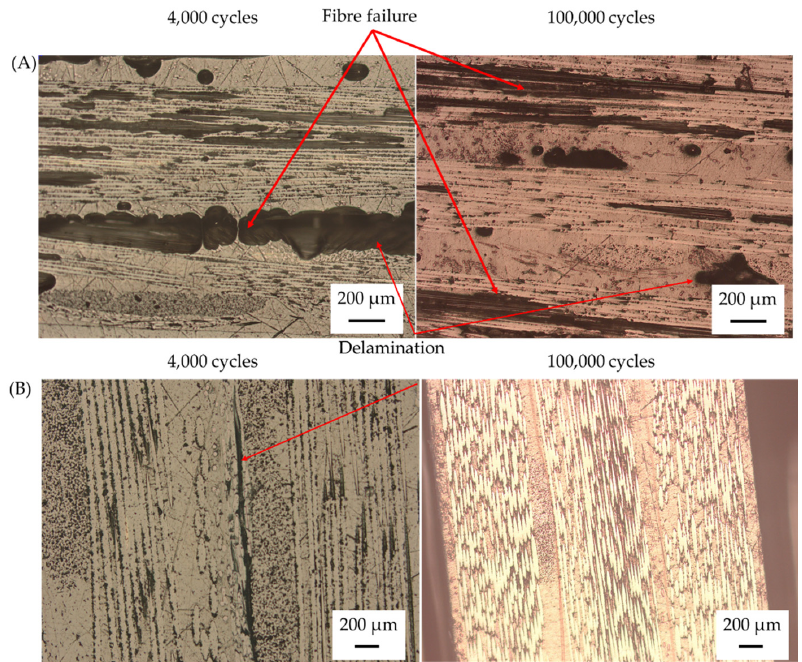
Figure 11. Optical imaging of glass fibre at 70% maximum loading: ( A ) GF after 4000 and 100,000 cyles and ( B ) veil toughened GFT after 4000 cycles and 100,000 cycles.